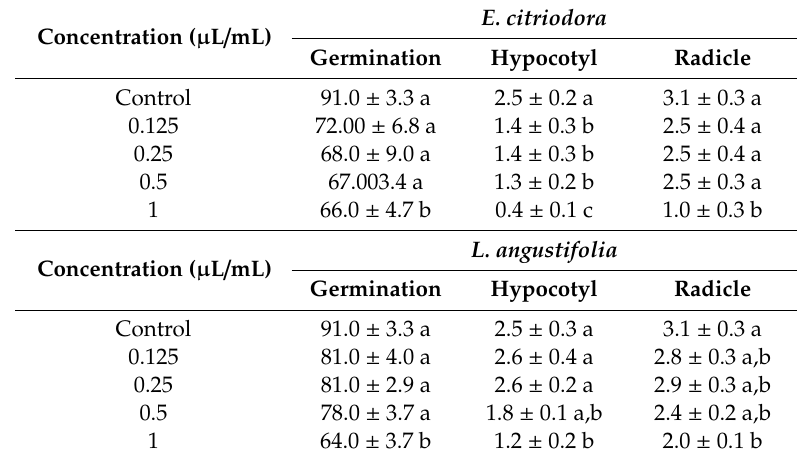
Table 3. In vitro phytotoxic e ff ect of di ff erent doses of E. citriodora and L. angustifolia essential oils on the seed germination and seedling growth of N.